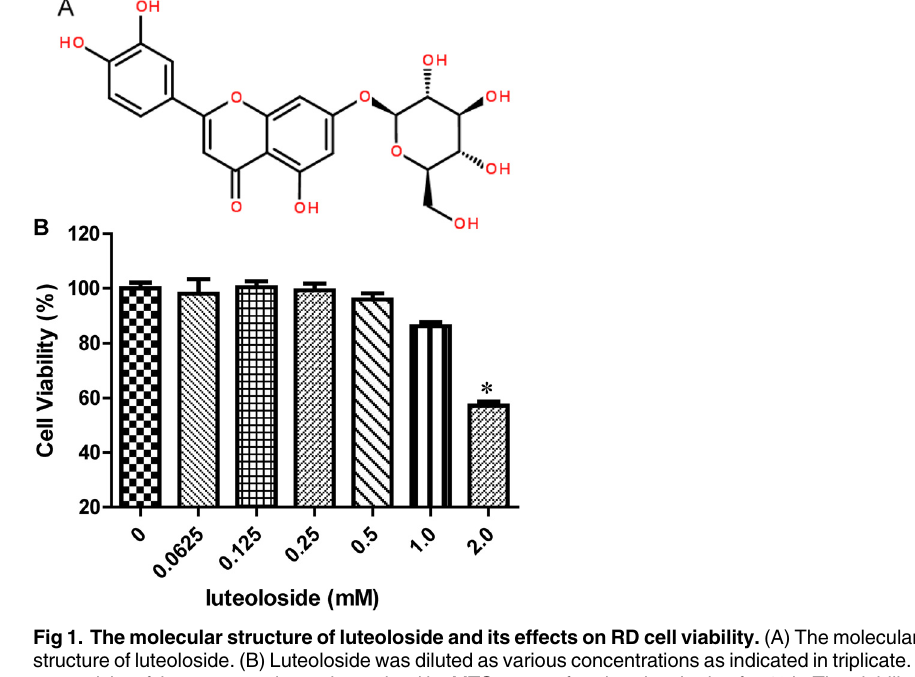
PLOS ONE | DOI:10.1371/journal.pone.0148693 February 12,